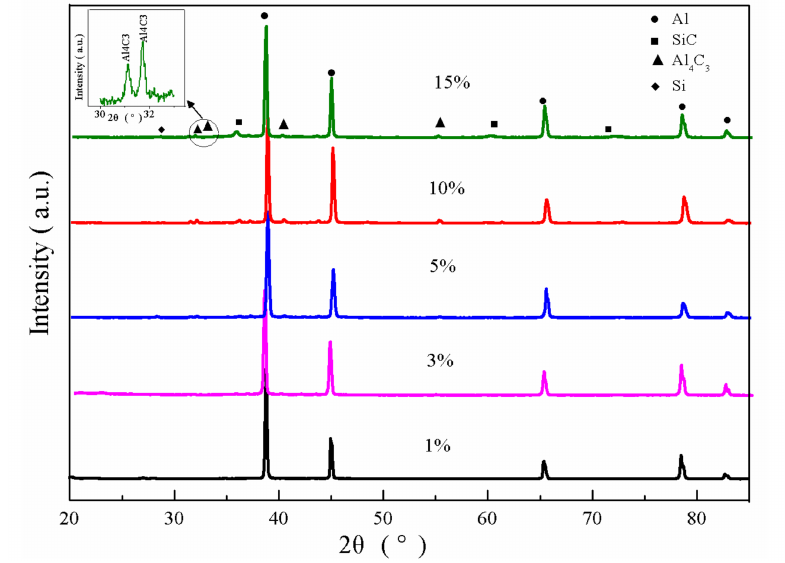
Figure 6. XRD di ff raction pattern of AA6061 / N-SiCp sintered at 4.5 GPa and 550 ◦ C with di ff erent content of N-SiCp